Question: Summarize what this figure shows in one sentence.
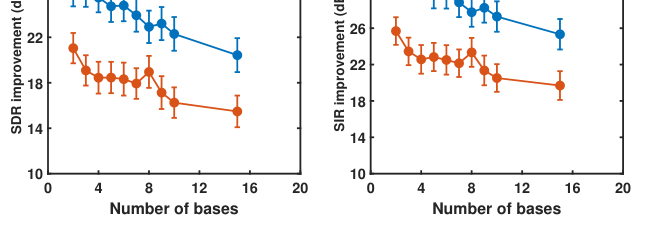
Answer: Average SDR and SIR improvements versus different number of bases. Conditions: source signals are from two female speakers in WSJ0 and there is no reverberation.